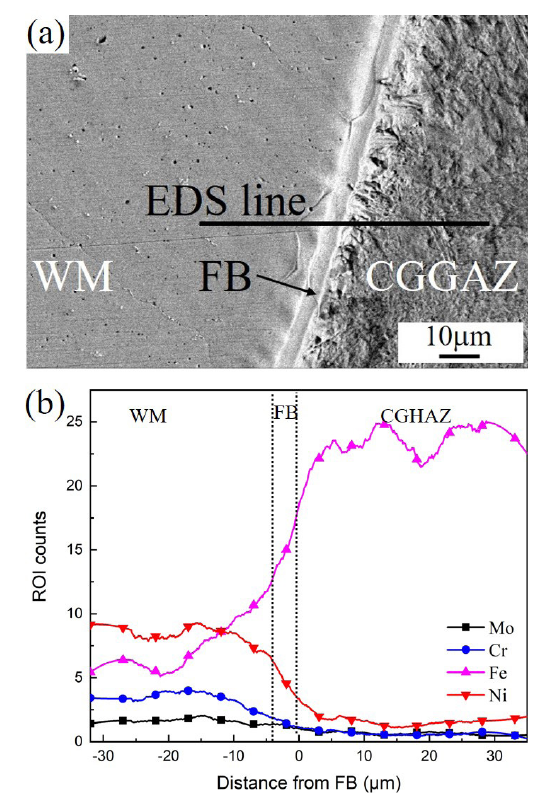
Figure 4. SEM and line scan of fusion